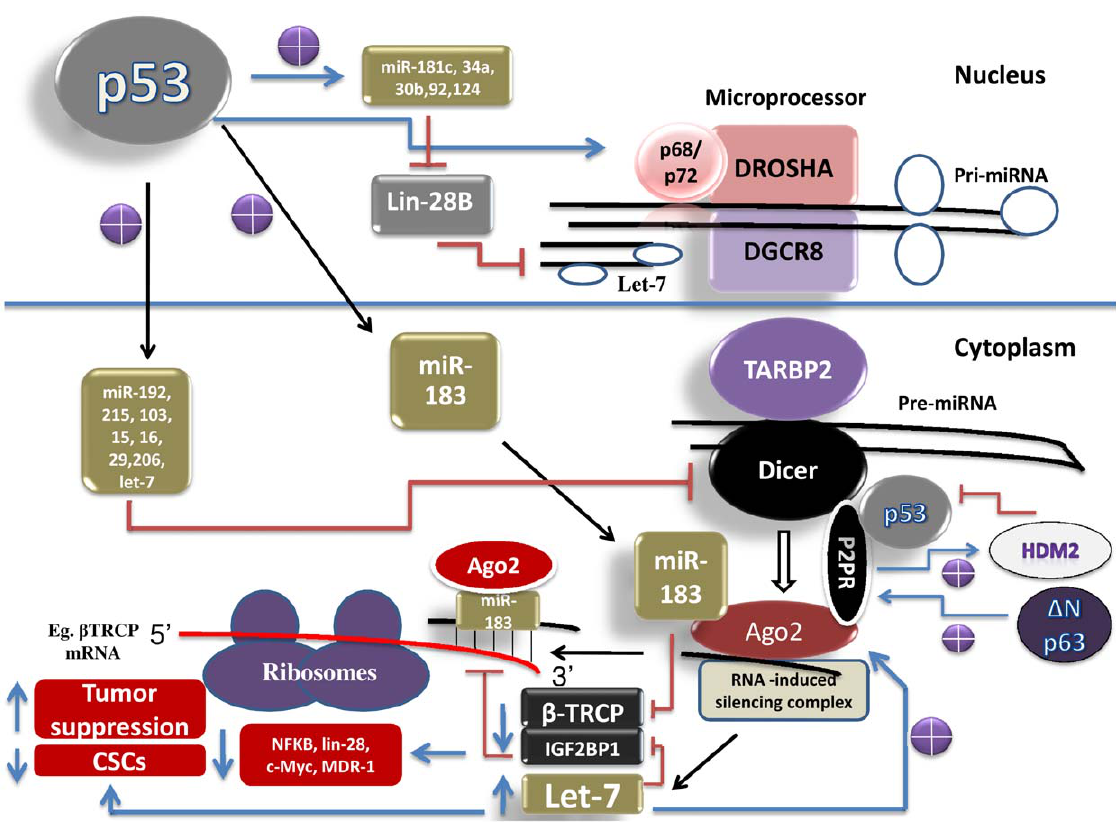
Figure 4. p53 is a regulator of microRNA-processing complex.